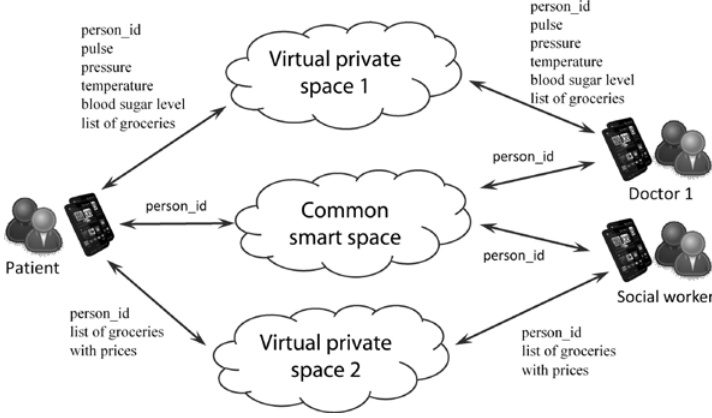
Figure 4: Usage Example Scenario of Information Exchange with Access